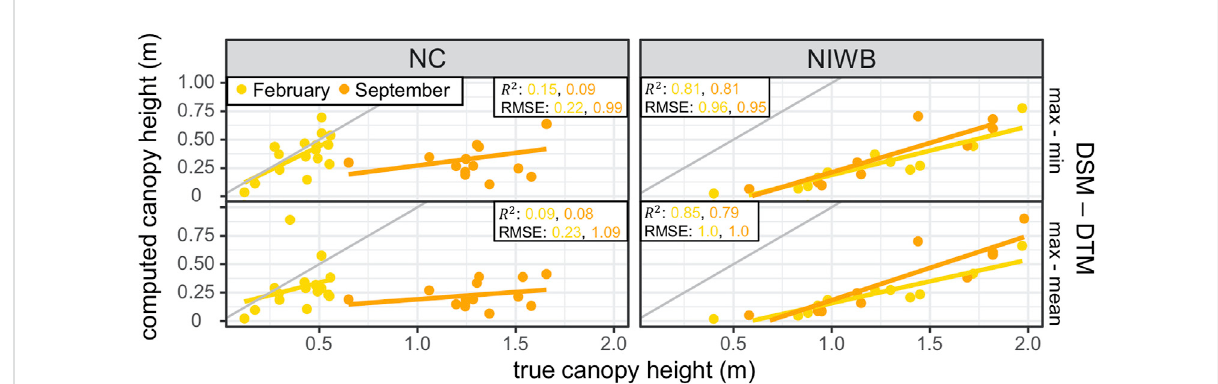
FIGURE 7 Computedcanopyheightunderpredictstruecanopyheight.DataisvisualizedbyseasonandNERRSsite.Eachpointrepresentsacanopyheight sampling plot from which ground data ( x -axis) and UAS-SfM computed data ( y -axis) were extracted. Red line represents the identity line. R 2 is assessed for individual linear relationships. Error is computed as the Root Mean Square Error (RMSE) observed vs expected data (error as it relates to the 1:1 line) are computed to assess the goodness of fi t. Subpanelsrepresent differences between DSM and DTM values within a given digitized sampling plot (e.g. max - min: maximum DSM value - minimum DTM value).